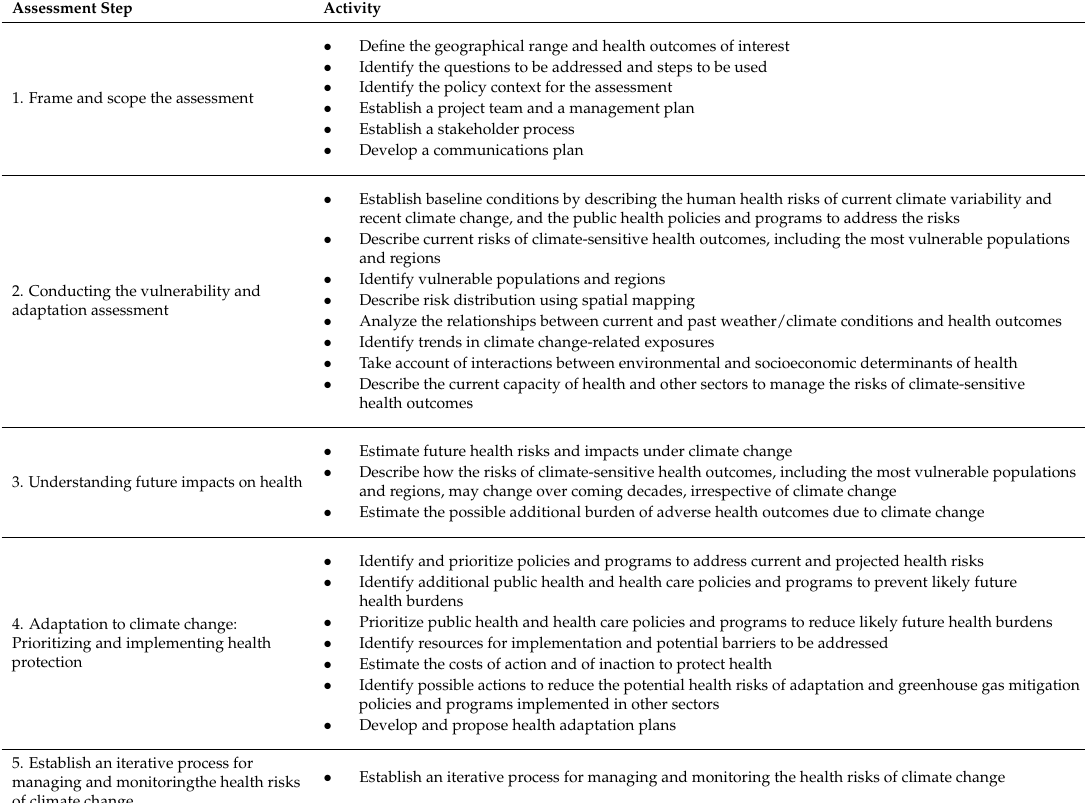
Table 1. Five steps for undertaking a climate change and health vulnerability and adaptation assessment. Source: